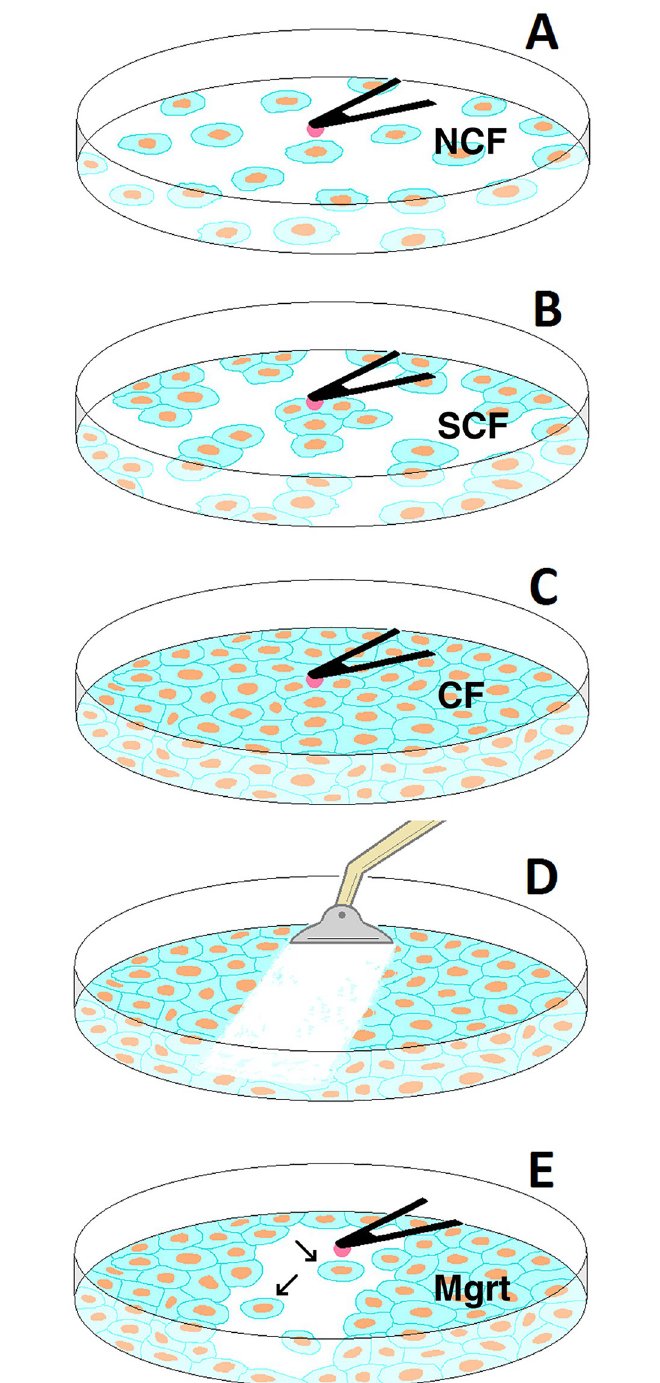
Fig 1. Diagram of EC growing states and AFM probing. Endothelial cells (green and orange) were cultured at NCF (A), SCF (B); and CF (C) status. For acquisition of Mgrt cells, a scratch in a straight line on EC monolayer was created using a cell scraper (D). After continued culture for two more days, individual Mgrt cells (indicated by arrows in E) from the leading edge of the scratch appeared in the scratched area. Cells at different status were probed by either tipped cantilever for EC stiffness measurement and topography, or by tipless cantilever (black triangle in A-C & E) coupled with aMB231 cell (pink in A-C & E) for measuring cancer cell-EC adhesion.